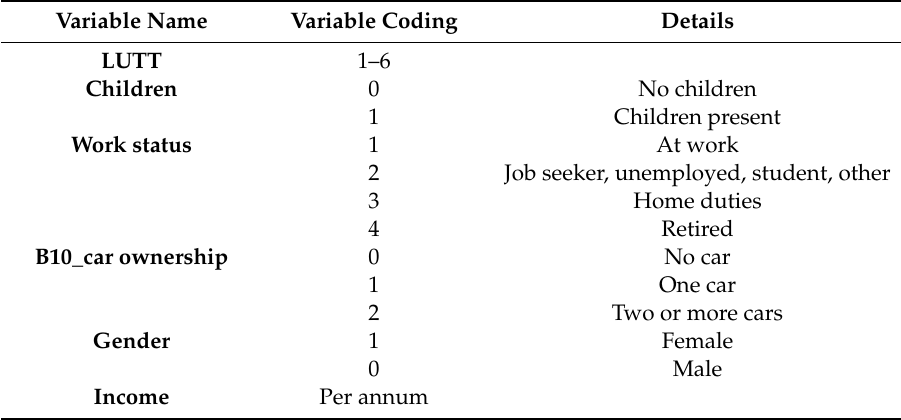
Table A8. Coding for Each